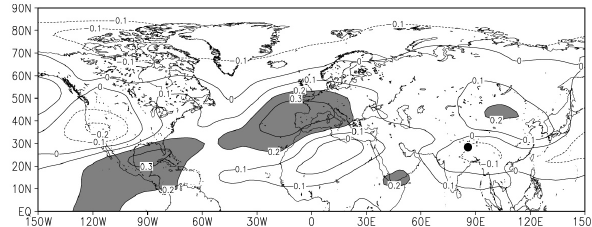
Fig. 7. Correlation coefficients between the annual mean DSP δ 18 O and mean air temperature during the non-monsoon season (October to May) at 400hPa level beginning from 1871. The monthly air tem- perature data with 2.0 ◦ × 2.0 ◦ resolution are from the 20th century reanalysis (V2). Grey shading indicates correlation significance at 95% confidence level. The filled black circle indicates the DSP core drilling site. Fig. 8. Composite analysis of summer mean (June to September)